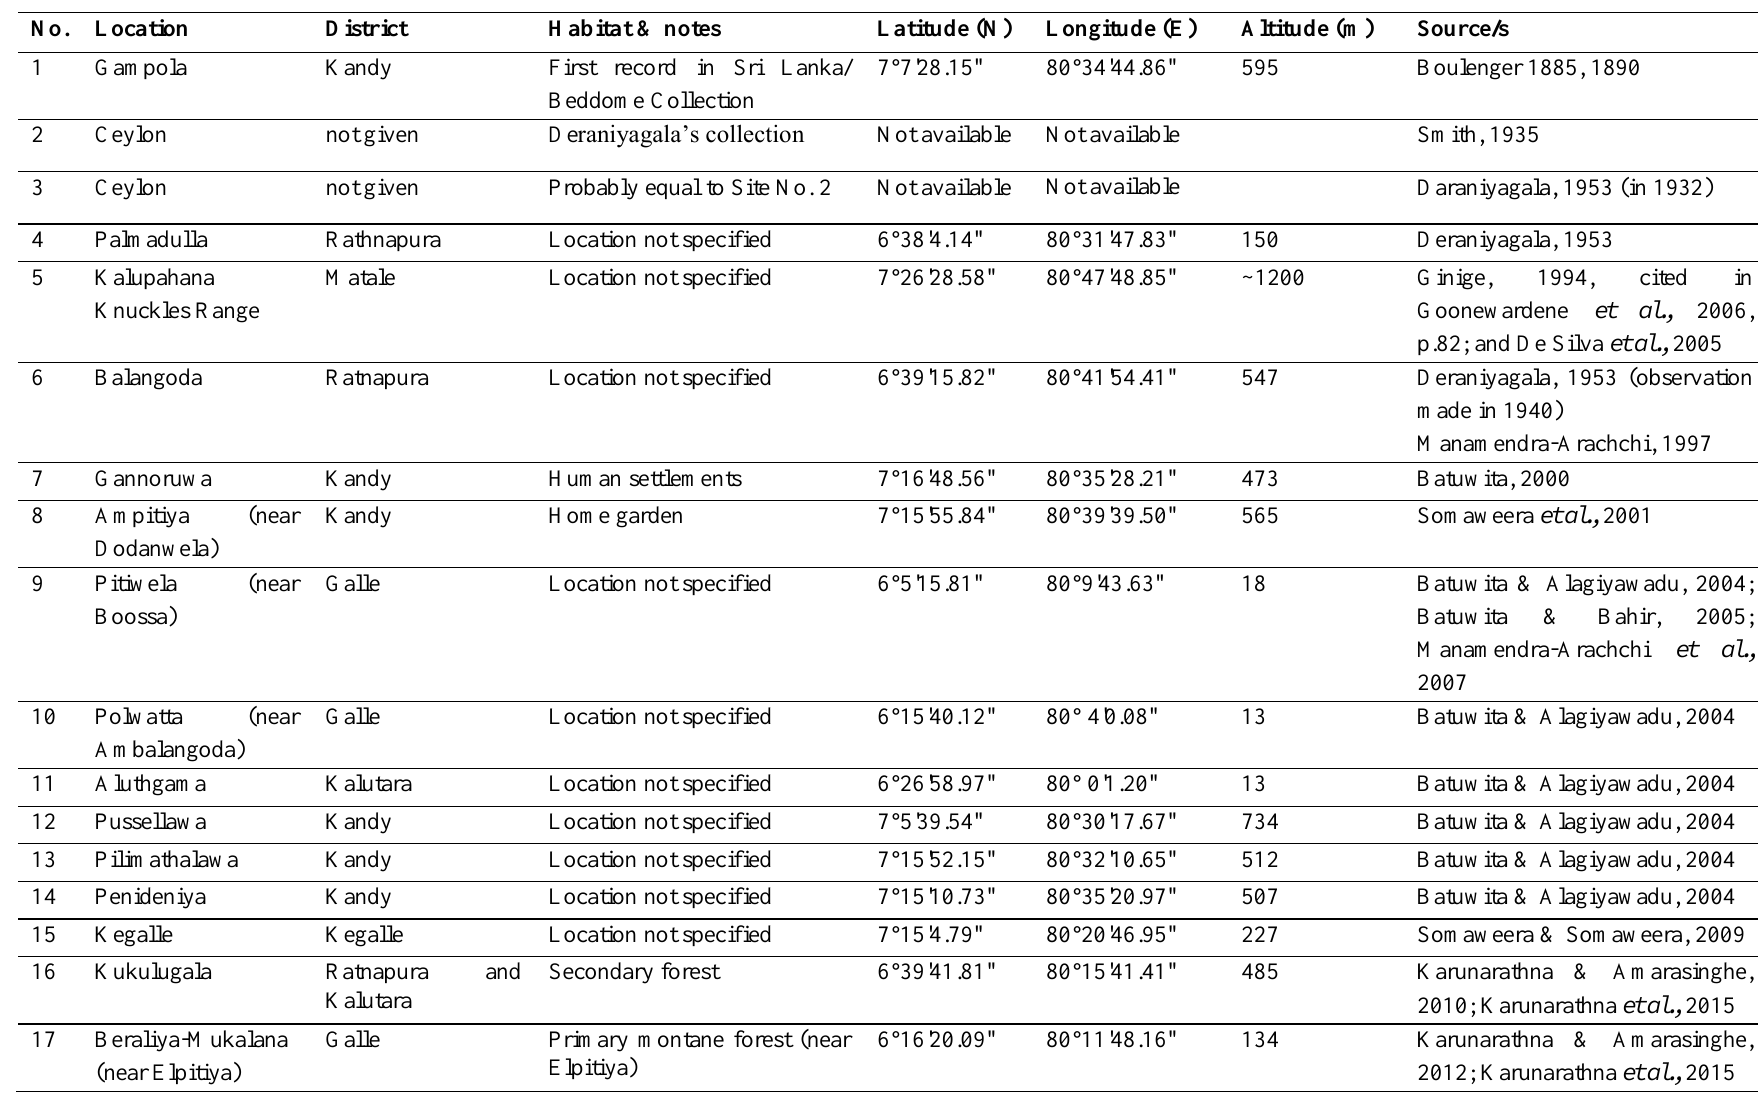
Table 1. Distribution sites and descriptions of published records including new localities of Hemiphyllodactylus typus in Sri